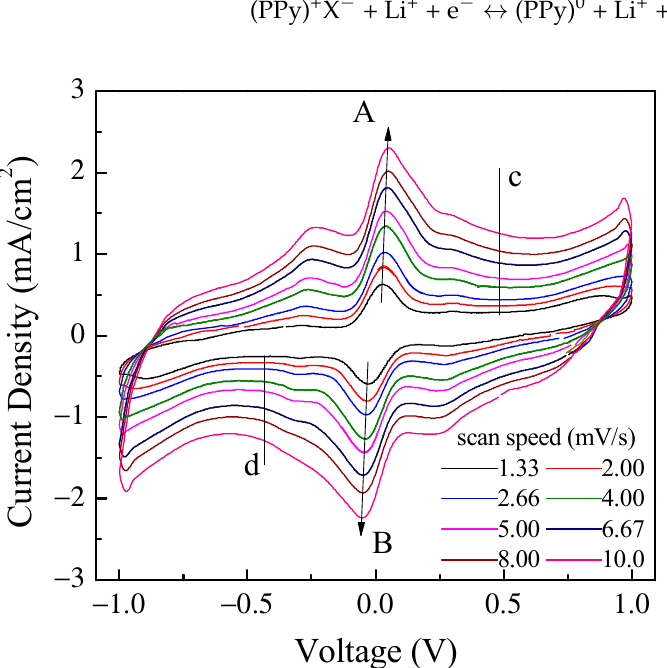
Figure 9. Current density–voltage loop of the same Au/PPy:DBSA/Nafion:LiPs/PPy:DBSA/Au cell that Figure 8 refers to measured at different scan speeds. The arrows mark the forward (A) and reverse (B) current density peaks, the intensity of which is reported in Figure 10a. The vertical lines marked c and d in the flat region of the inner loop identify the voltage V c (V d ) at which the forward (reverse) current density data displayed in Figure 10b are taken from.